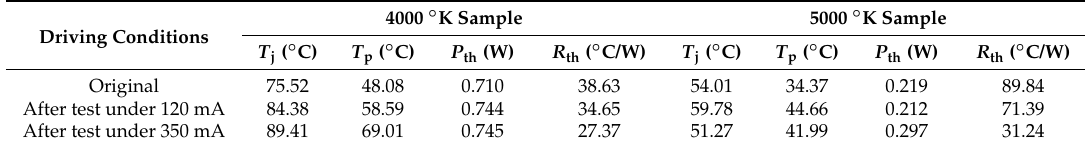
Table 3. Thermal properties of test samples before and after SSADT.